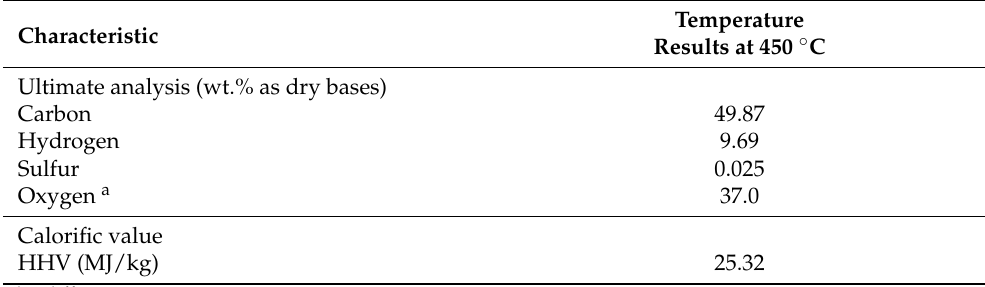
Table 2. Properties of optimum bio-oil.